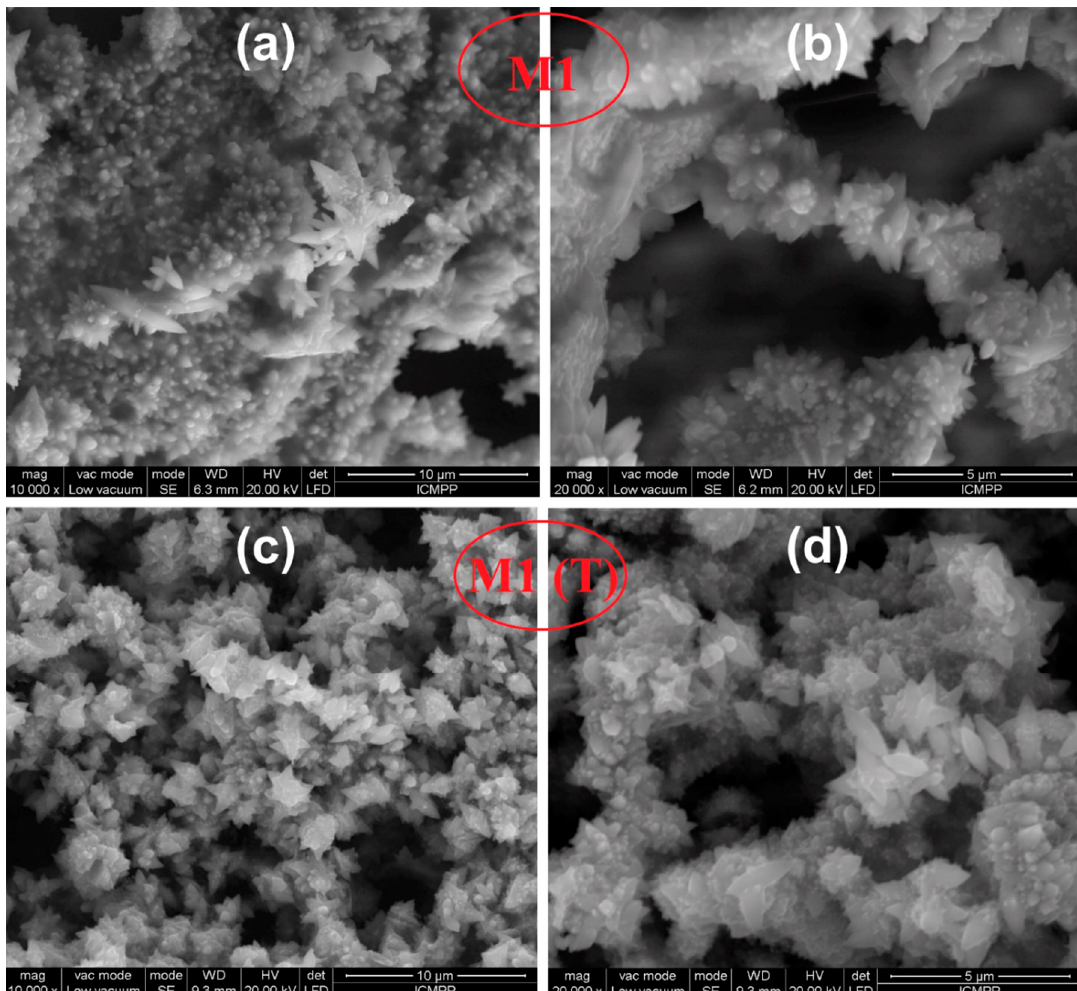
Figure 4. SEM images of CAB / ZnO hybrid nanostructures obtained by the dipping method after thermal treating at 240 ◦ C in the air for 1 h (( a ) and ( b ) for M1 ), and carbon / ZnO after thermally treating at 600 ◦ C in N 2 for 30 min (( c ) and ( d ) for M1 (T) ). The materials obtained by the hydrothermal method ( M2 and M2 (T) ) show a nanorod type structure with an average diameter of about 700 nm and lengths around 5 µ m according to the SEM images represented in Figure 5.